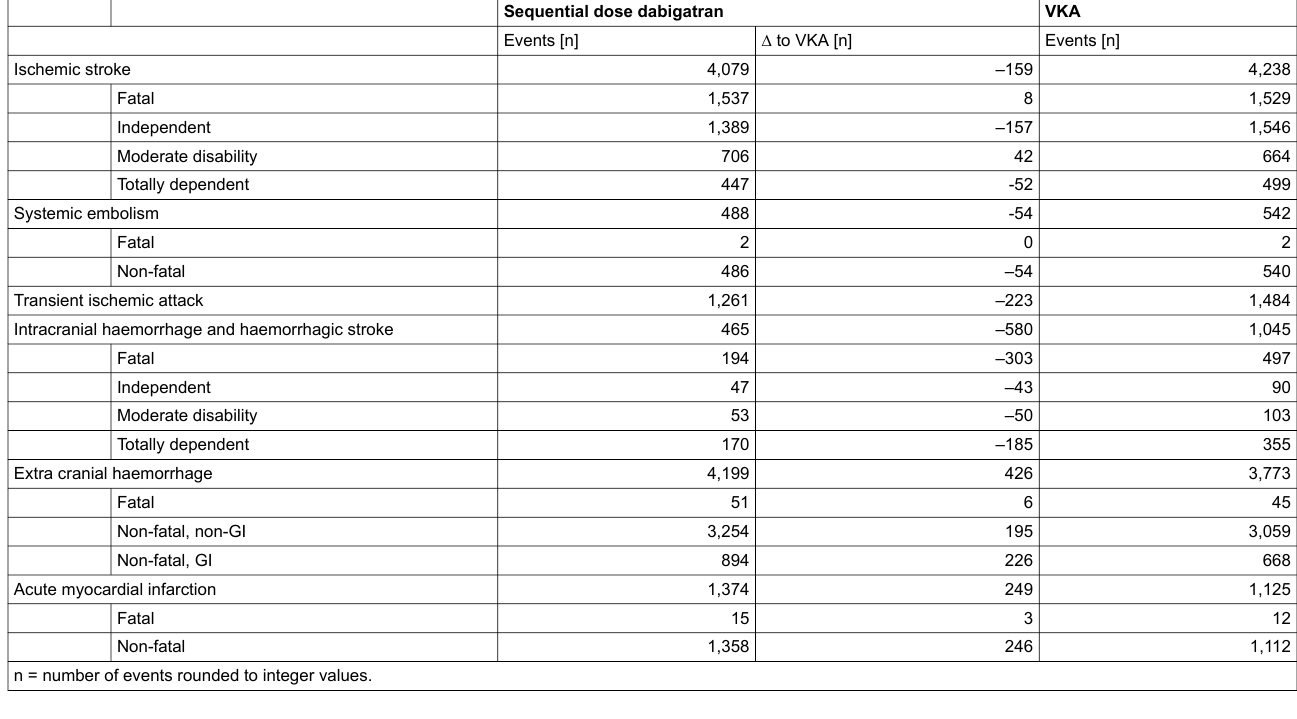
Table 5: Number of events in the sequential dose model. The number of events represents the sum of clinical events of all 10,000 patients over their entire time in the model. The difference to the number of events in the VKA arm is the result of relative effectiveness and lifetime of patients. As the sequential dose scenario is modelled on a slightly different sub-population of the RE-LY trial, the comparison of the results of the sequential dose scenario with the other two scenarios should be limited to the comparison of the ICER and should not include a comparison of the number of clinical events prevented.